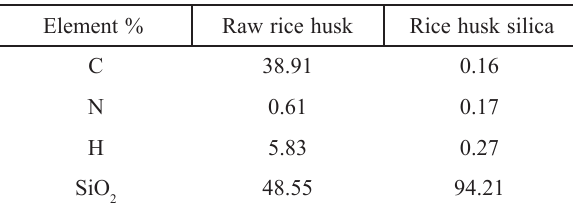
Table 1 – Results of chemical analysis of raw rice husk and rice husk silica